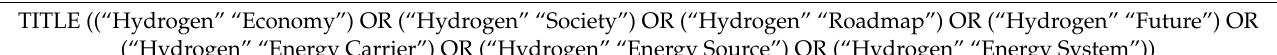
SCOPUS Search Query